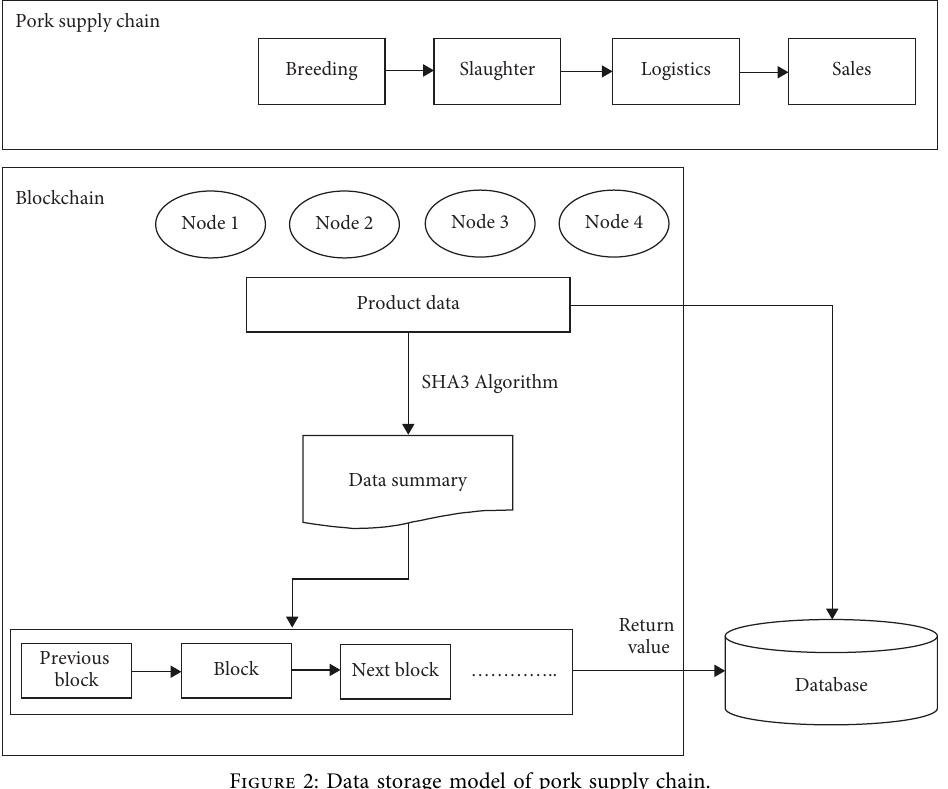
Figure 2: Data storage model of pork supply chain.